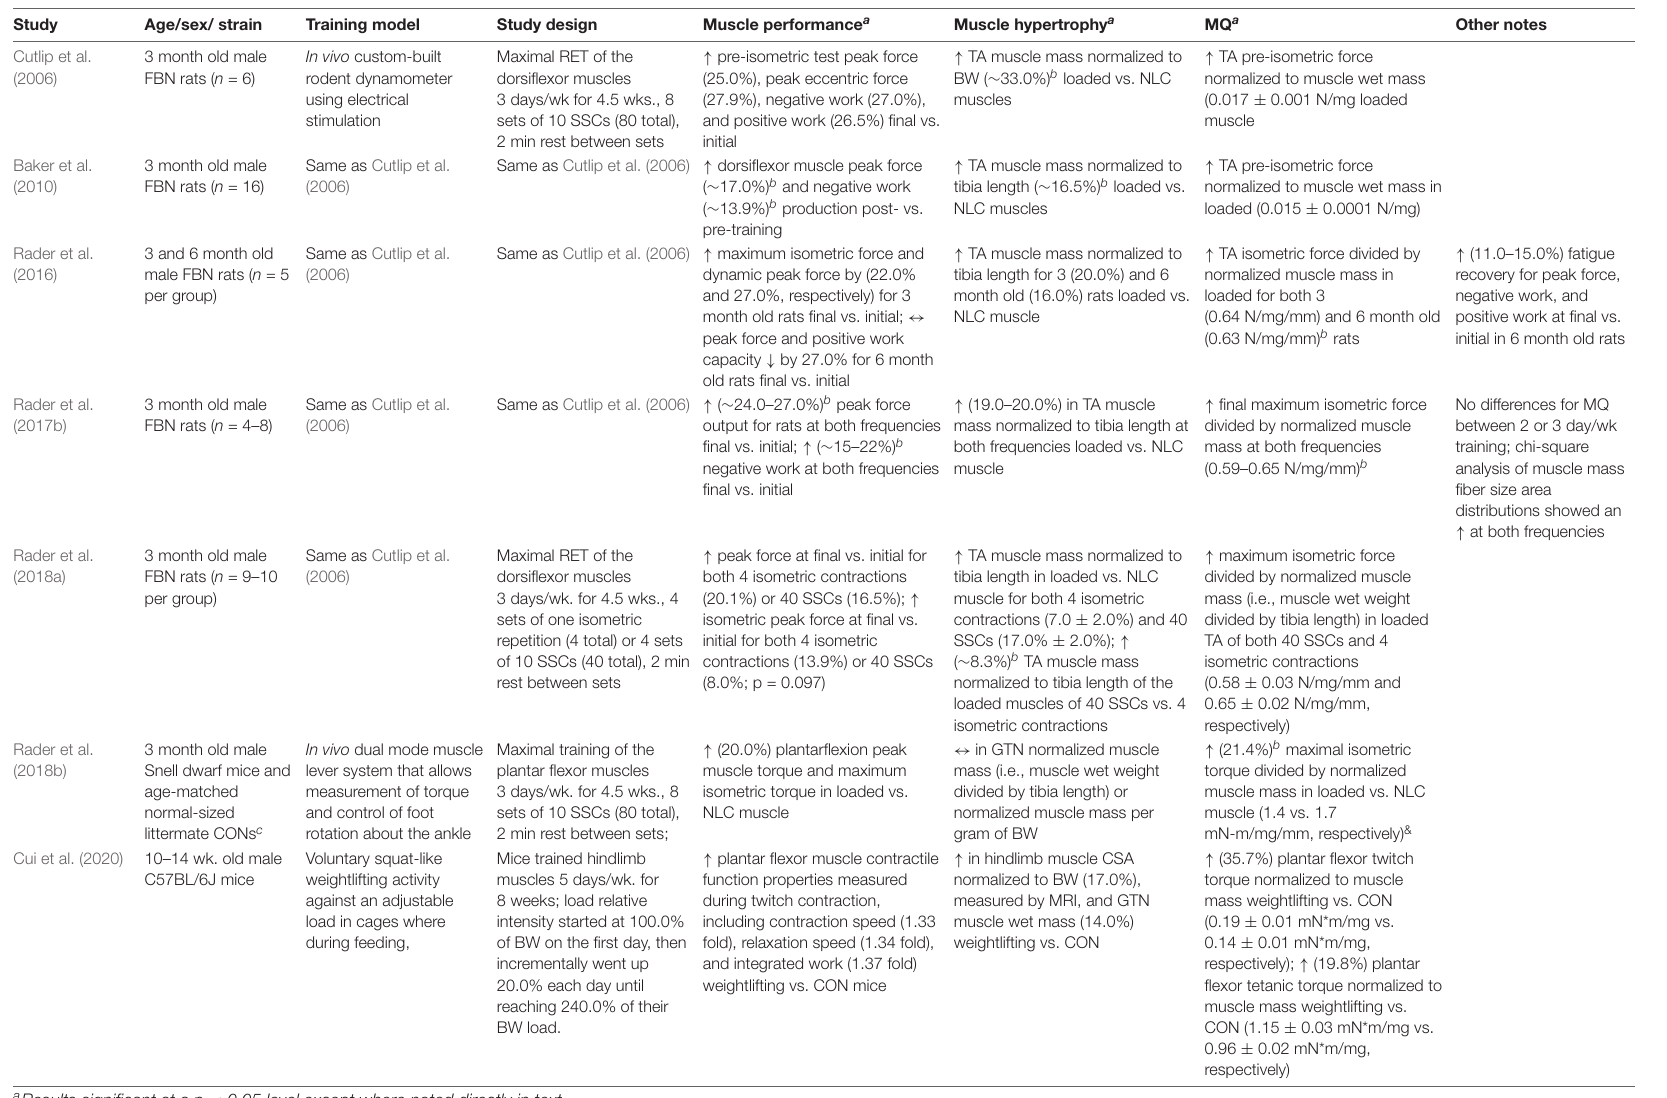
TABLE 4 | Effects of high-intensity RET on MQ in young rodent animal models. Study